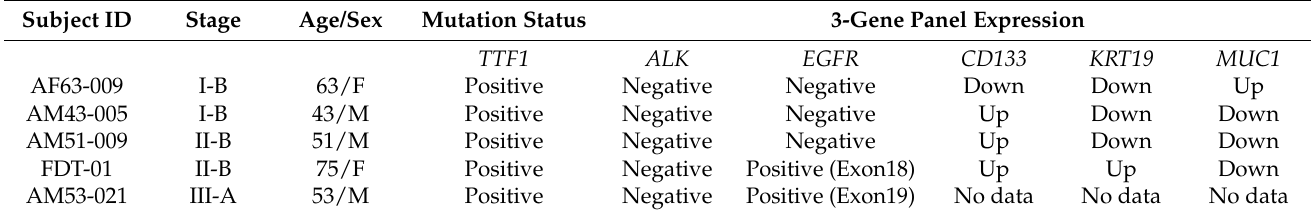
Table 1. Demographic and genetic profiles of the five Filipino lung cancer patients in the